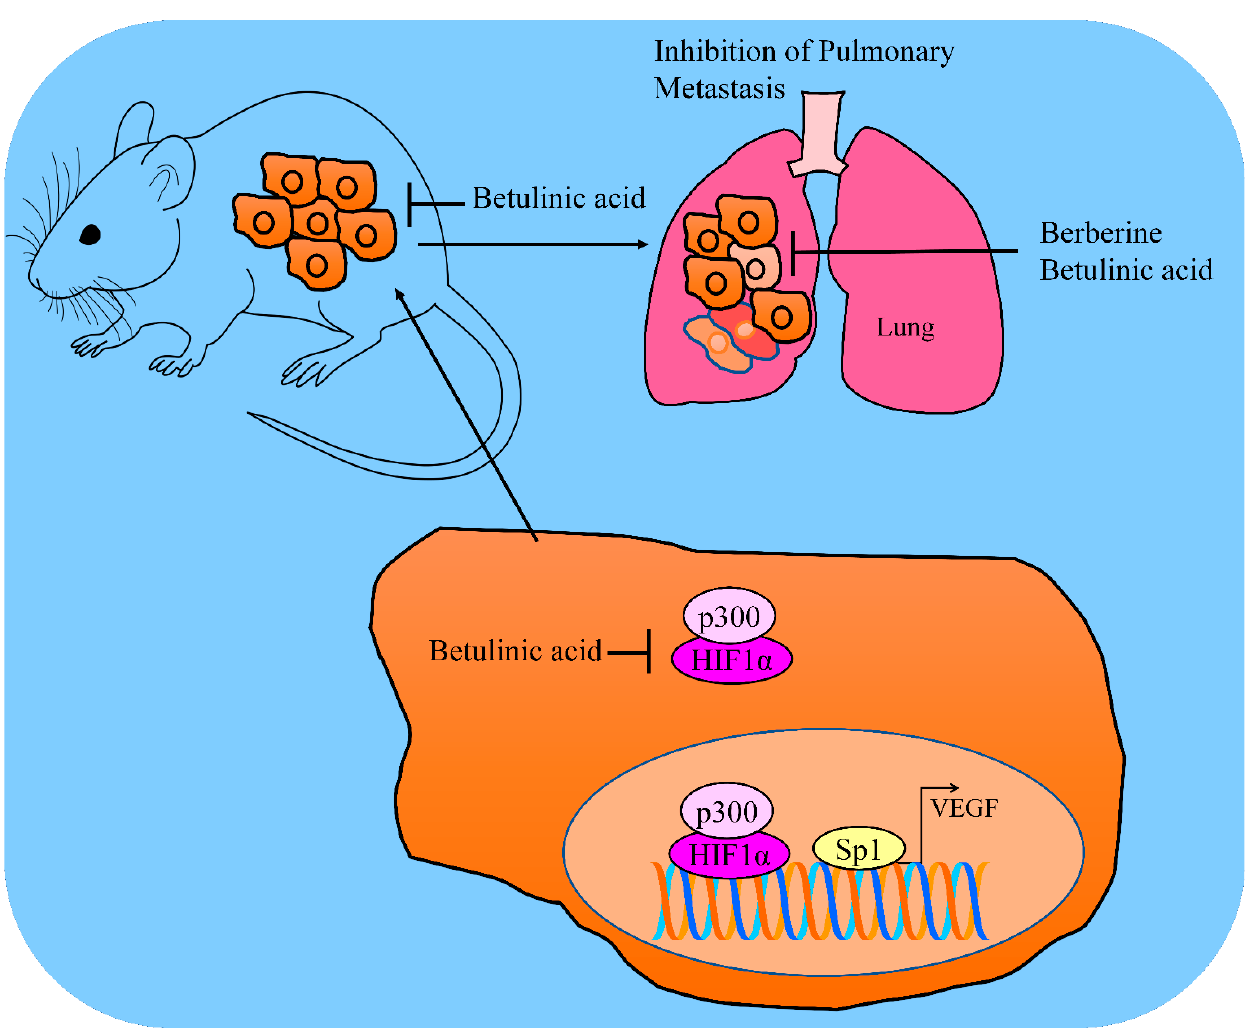
Figure 2. Betulinic acid mediated inhibition of HIF1 α and Sp1 mediated upregulation of VEGF. Betulinic acid inhibited the tumorigenesis and metastasis in animal models. Betulinic acid attenuated pulmonary metastatic nodules in mice. Abbreviations: Hypoxia inducible factor (HIF), Vascular endothelial growth factors (VEGF), Histone acetyltransferase p300, Specificity protein (SP).